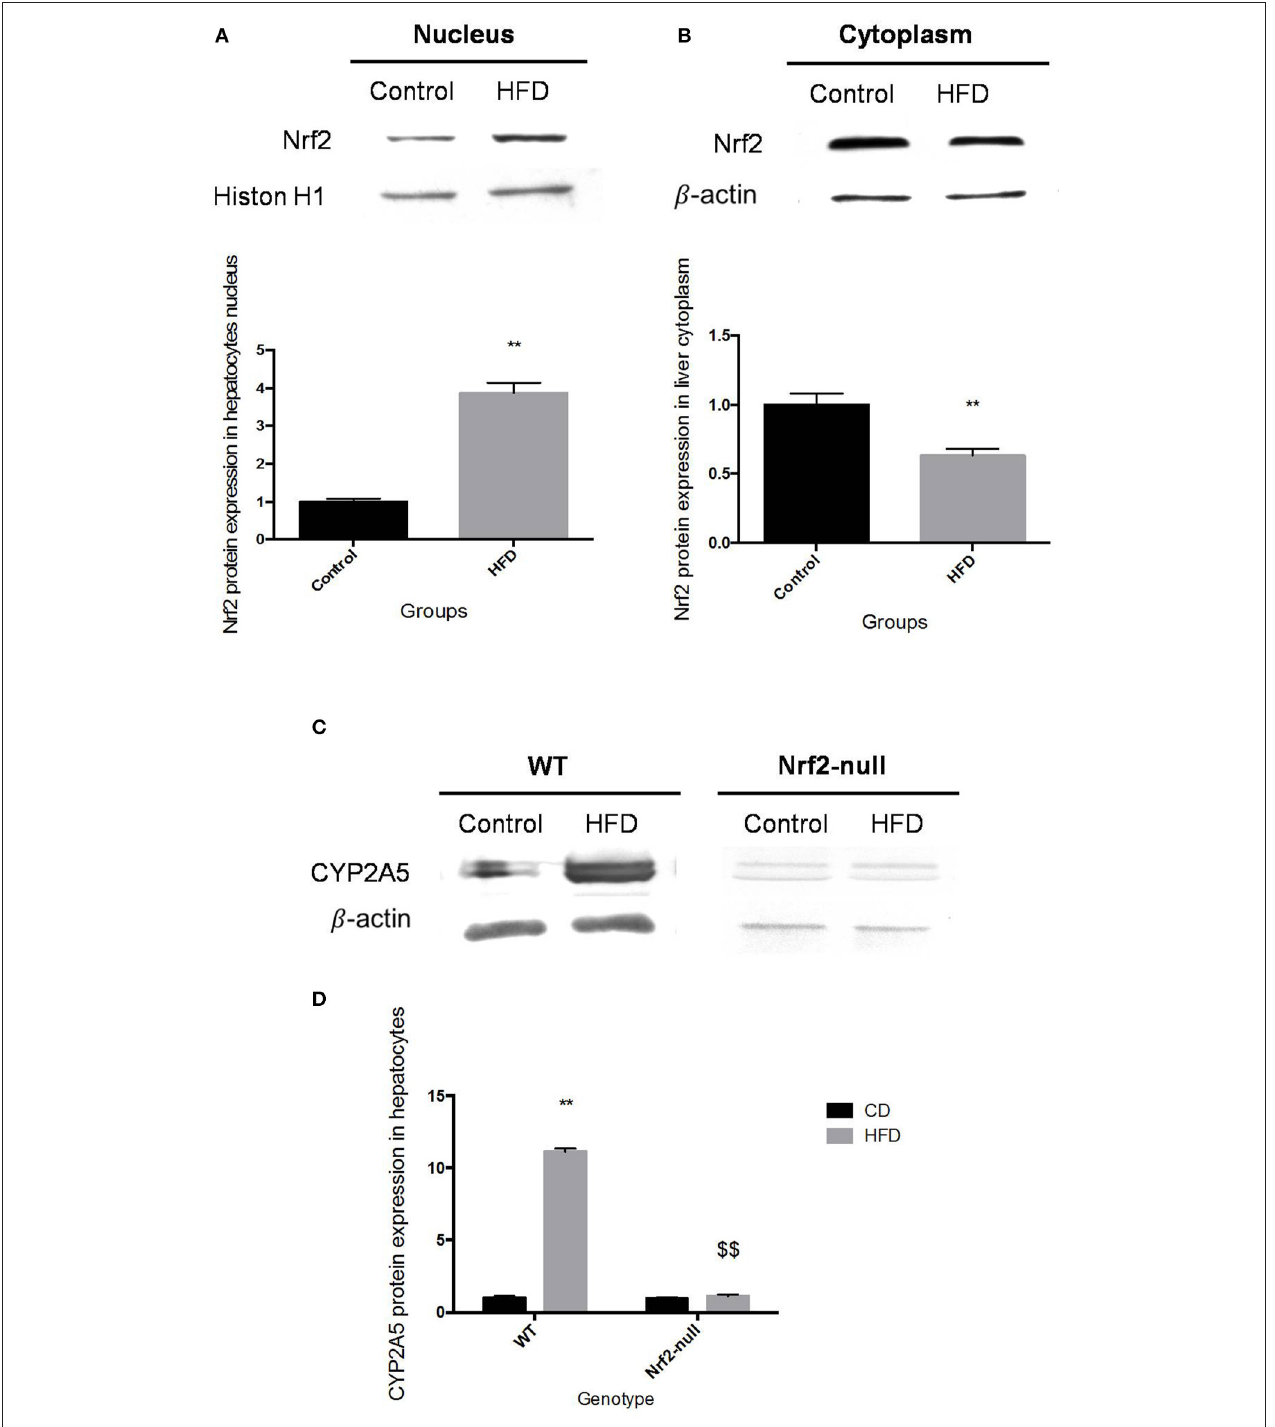
FIGURE 2 | Nrf2 and CYP2A5 protein expressions in HFD feeding mice. Nrf2 protein expression in mouse hepatocytes nucleus and its quantity relative to Histon H1 is shown in panel (A) . Nrf2 protein expression in liver cytoplasm and its quantity relative to β -actin is shown in panel (B) . Hepatic CYP2A5 protein expression in WT and Nrf2-null mice, which fed with CD and HFD, is revealed in panel (C) and the quantity relative to β -actin is shown in panel (D) . * represent statistical difference caused by HFD within WT or Nrf2-null groups; $ represent statistical difference caused by Nrf2 deficiency on the same diet. * 0.01 < P < 0.05, ** P < 0.01; $ 0.01 < P < 0.05, $$ P <